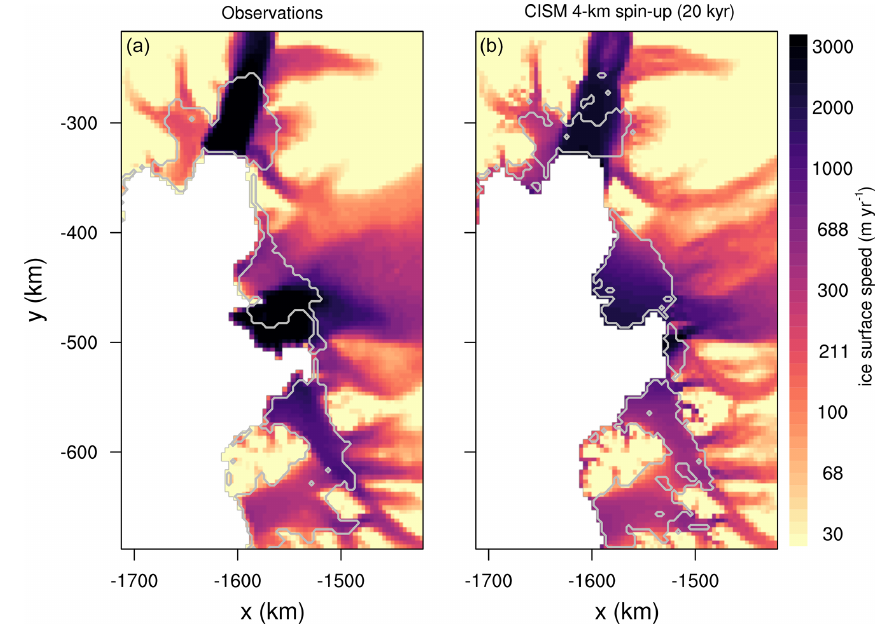
Figure 5. Same as Fig. 4, but focused on the Amundsen sector. Light gray lines show boundaries of floating